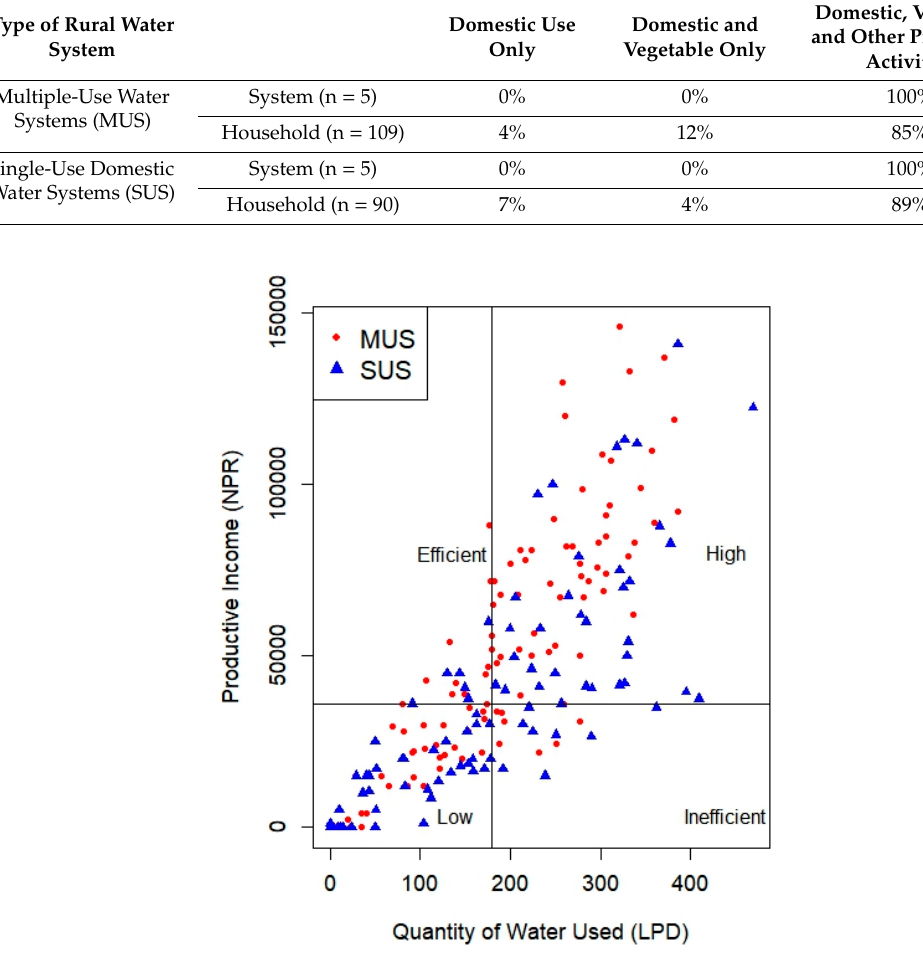
Table 2. Descriptive statistics for four levels (low, high, efficient, and inefficient) of households.